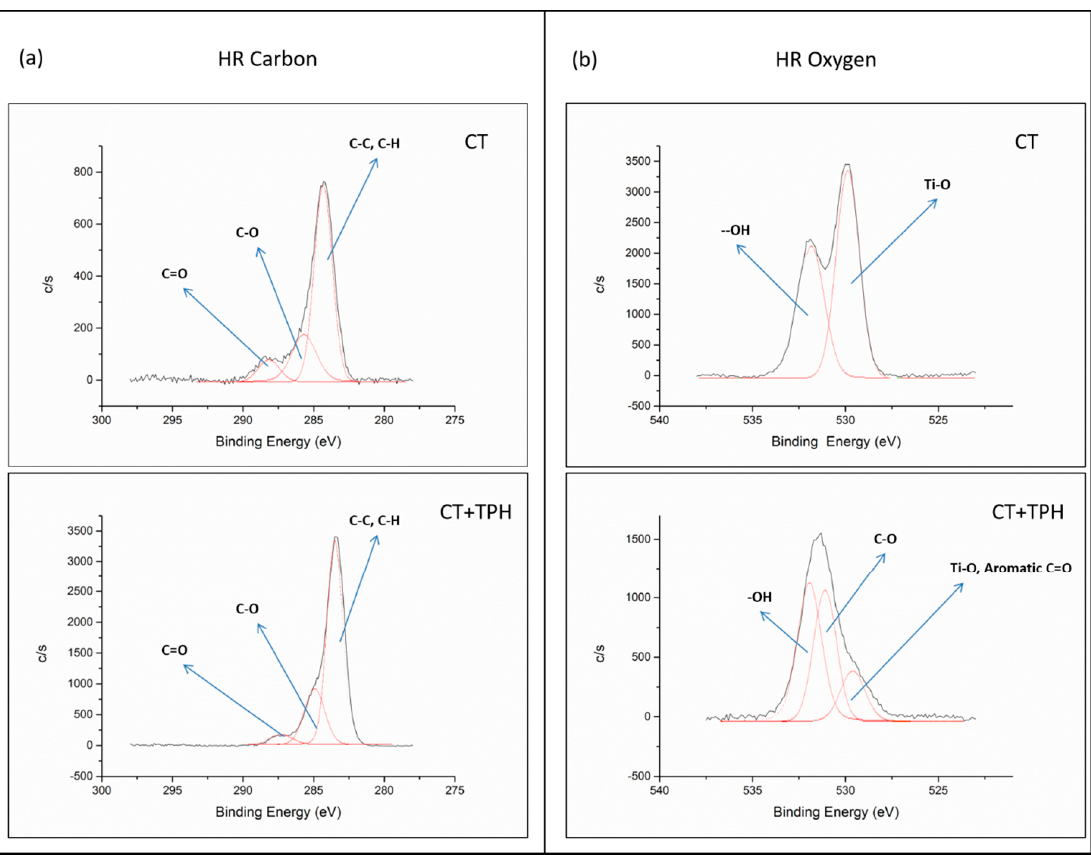
Figure 1. XPS high resolution (HR) spectra of ( a ) C1s and ( b ) O1s of sample CT and CT + TPH.